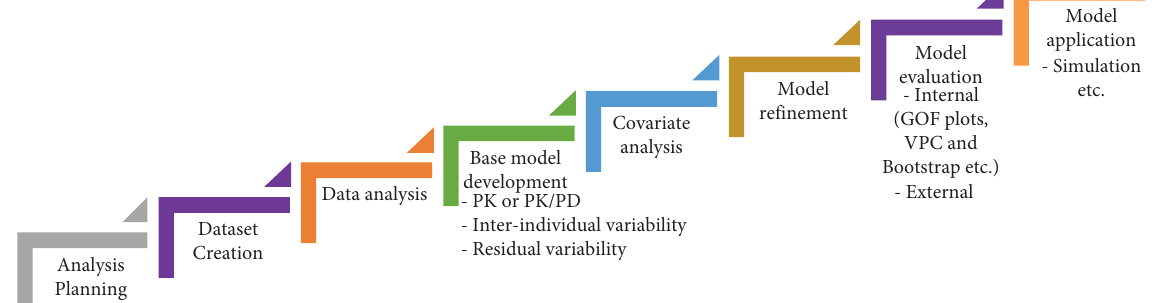
Figure 2: Use of pharmacometrics for dose tailoring. GOF: goodness-of-ft; VPC: visual predictive